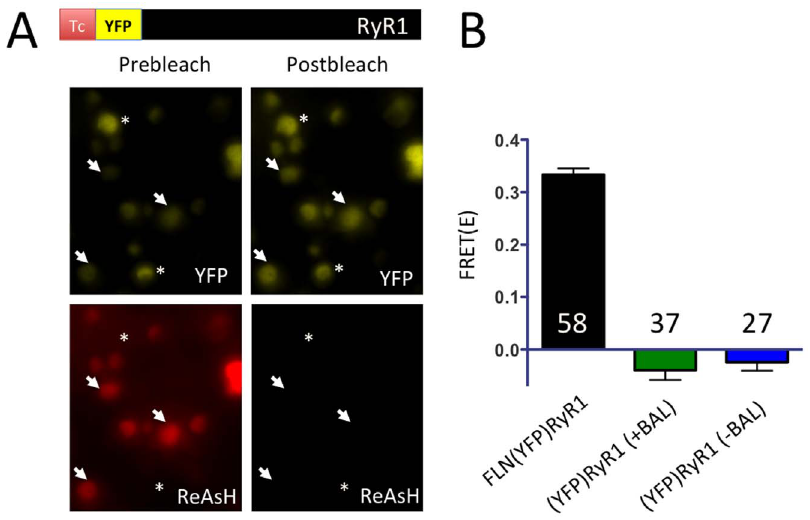
Figure 3. FRET measurements of FLN(YFP)RyR1 labeled with ReAsH. (A) BAL-washed HEK-293T cells expressing ReAsH-labeled FLN(YFP)RyR1 were examined for YFP (top panels) and ReAsH fluorescence (bottom panels) both before (left panels) and after (right panels) photobleaching of ReAsH. Donor fluorescence increased after acceptor photobleaching due to FRET only for those cells initially labeled with ReAsH (arrows) whereas cells that were not initially ReAsH-labeled did not display FRET (asterisks). (B) Mean FRET efficiencies are shown for FLN(YFP)RyR1 (black bar) or (YFP)RyR1 that had either been postwashed with 0.25 mM BAL for 15 9 (green bar) or that was not treated with BAL (blue bar). Values represent mean + / 2 S.E.M. for the number of cells indicated in each bar.